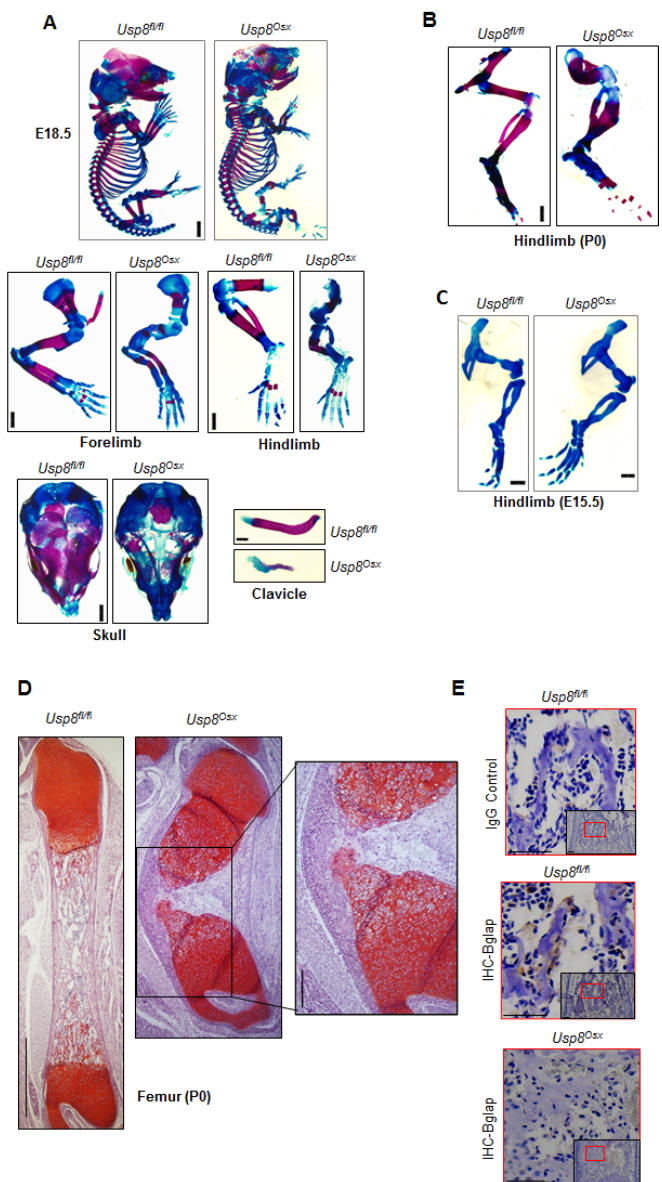
Figure 3. Usp8 Osx mice display impaired ossification during skeletogenesis. ( A ) Alizarin red/alcian blue staining of skeletal preparations of whole body, forelimbs, hindlimbs, skull, and clavicle of E18.5 Usp8 fl/fl and Usp8 Osx embryos ( n = 3/group). Scale bar, 1mm. ( B , C ) Alizarin red/alcian blue staining of skeletal preparations of hindlimbs of P0 neonates (B, n = 3/group) and E.15.5 embryos (C, n = 3/group). Scale bar, 1mm. ( D ) Safranin O–stained longitudinal sections of P0 Usp8 fl/fl and Usp8 Osx femurs ( n = 3/group). Scale bar, 250 µ m (left) and 100 µ m (right, enlarged insert image). ( E ) Immunohistochemistry (IHC) for Bglap in the trabecular bone of P0 Usp8 fl/fl and Usp8 Osx femurs ( n = 3/group). Upper: IgG control, middle and down: IHC for Bglap. Scale bar, 100 µ